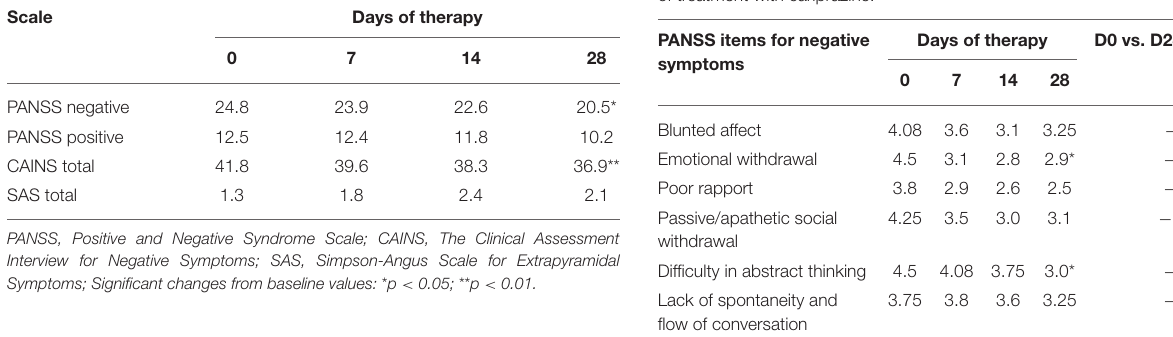
TABLE 4 | Change from baseline in negative symptom scores for separate items of the Positive and Negative Syndrome Scale (PANSS) during the first four weeks of treatment with